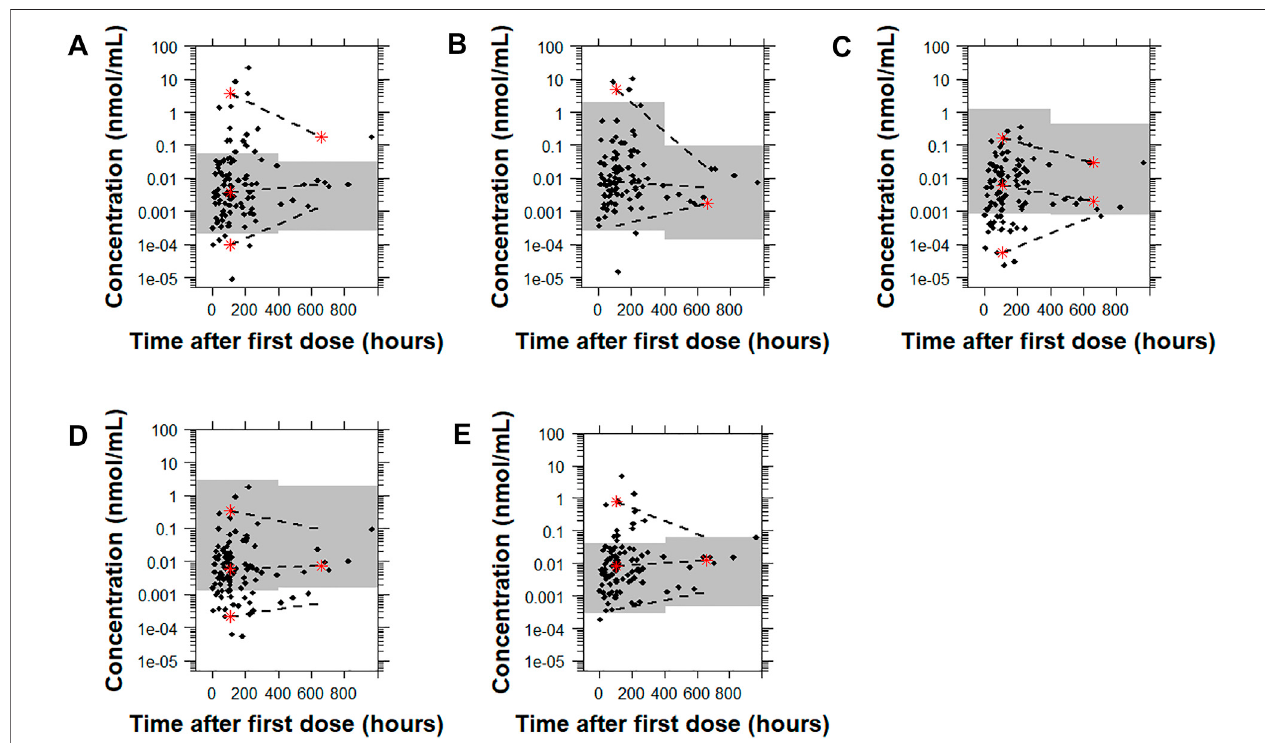
FIGURE6| Prediction-correctedvisualpredictivechecks(pcVPCs)oftheobserveddataoverlaidonthepredictionsobtainedbyperforming1,000simulationswith eachrisperidonepopulationpharmacokineticmodel.Model (A) :Kloosterboeretal.,2021;Model (B) :Sherwinetal.,2012;Model (C) :Fengetal.,2008;Model (D) :Feng et al., 2008 with allometric scaling; and Model (E) : Thyssen et al., 2010. All pcVPC plots are based on the time after the fi rst dose. The dashed lines represent the 5th, 50th, and 95th percentiles for the observed data, and the gray shaded regions are the 95% prediction interval for the predicted concentrations. The red stars indicate outlying percentiles of the observed data from the prediction interval. The y axis is in log-transformed scale. The x axis represents the time after fi rst recorded dose. A sample that was collected later than 1,000 h after the fi rst recorded dose was omitted from the graphs to improve visualization. The point was within the prediction interval for all of the models tested except for Model